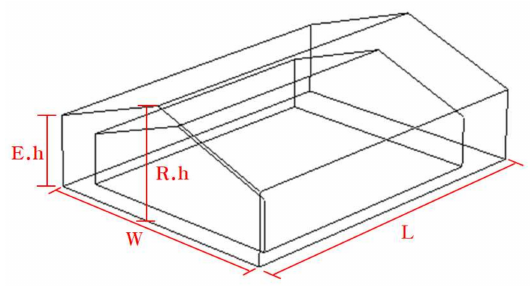
Figure 1. Heating device installation overview. ( a ) Photograph of the experimental greenhouse, ( b ) inside view of the greenhouse, ( c ) water-to-water heat pump and water tank, ( d ) pellet boiler, ( e ) air-to-air heat pump, ( f ) ceiling radiator.